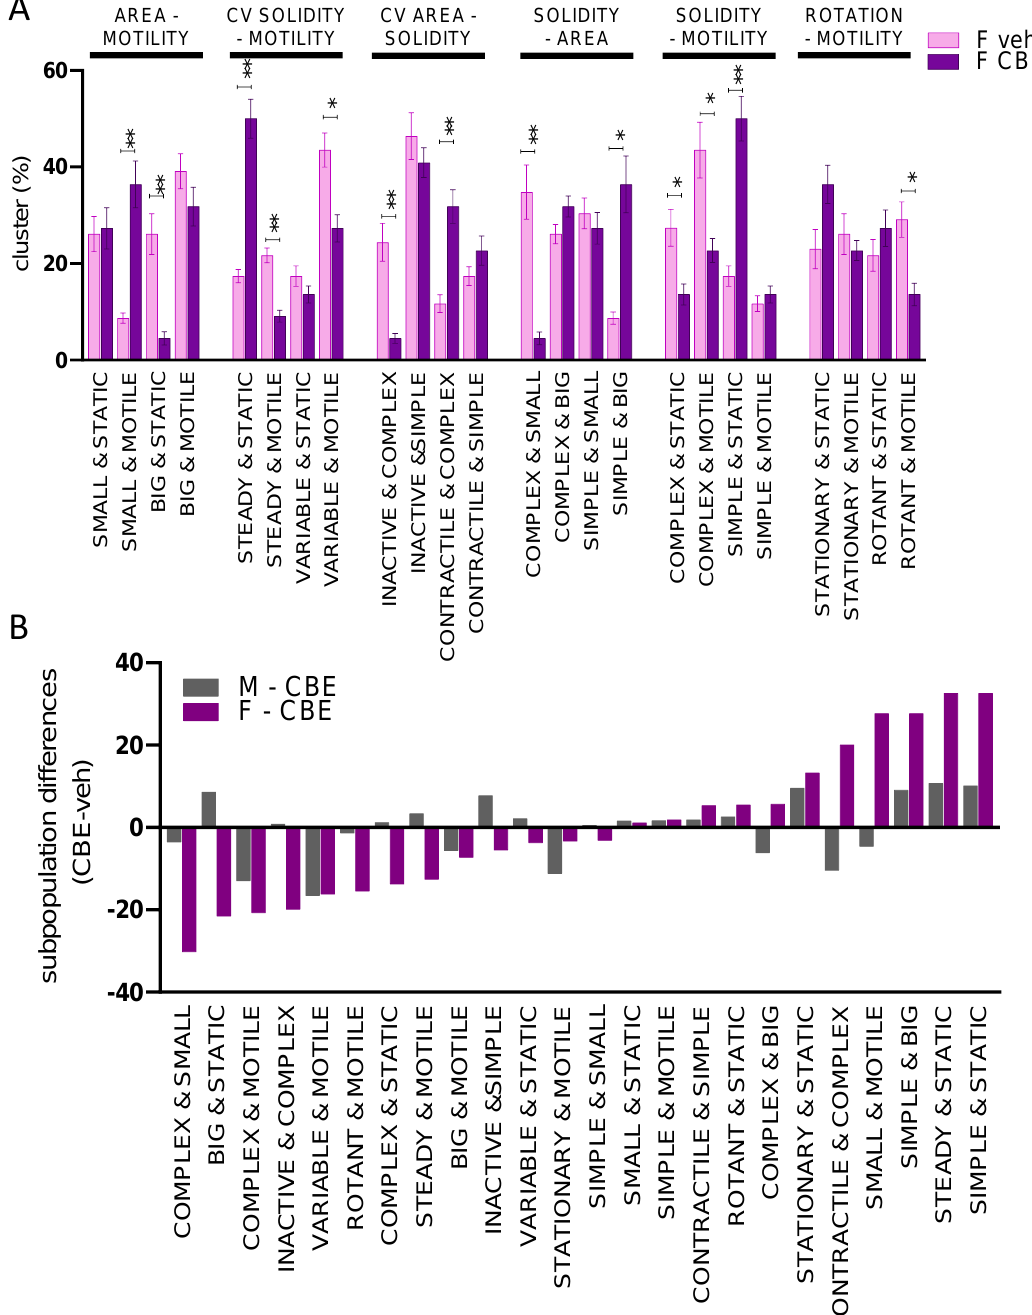
Figure 5. Morpho-functional biparametric analysis of CBE-treated female microglia. ( A ) Biparametric analysis represented as a histogram of the median ± SEM of the subpopulation percentage obtained in 3 different experiments. The two parameters obtained to generate the clusters are reported on the top of the graph. * p < 0.05, ** p < 0.01 calculated by t -test versus vehicle. ( B ) Variation in subpopulation composition for CBE-treated male (Figure 4A) and CBE-treated female ( A ) microglia versus the vehicle-treated cells.